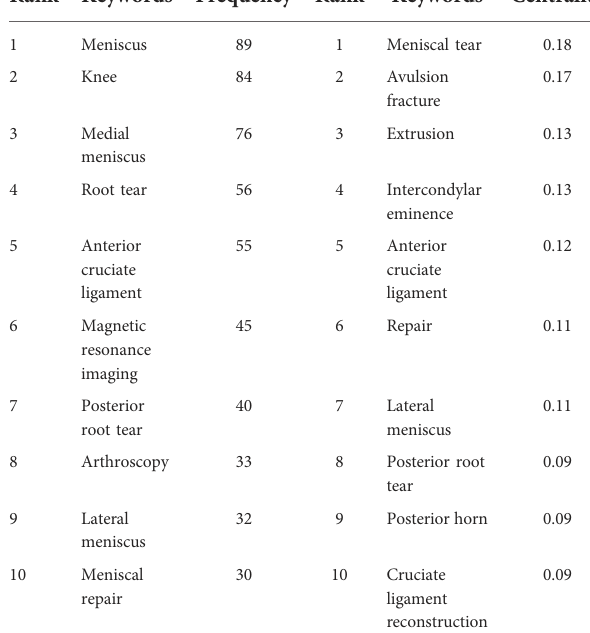
TABLE 8 The top 10 author keywords by frequency and